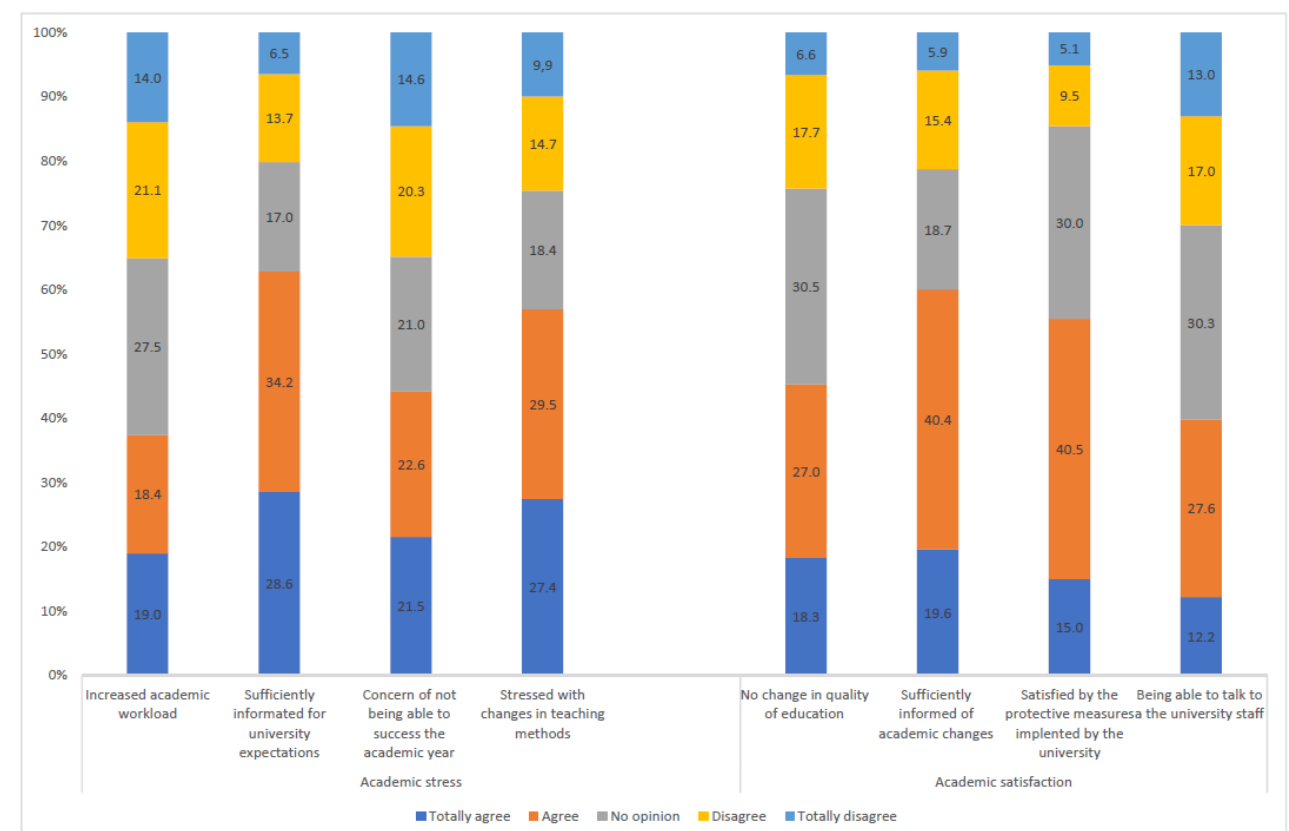
Figure 1. Academic stress and academic satisfaction of the university students ( n = 3671).